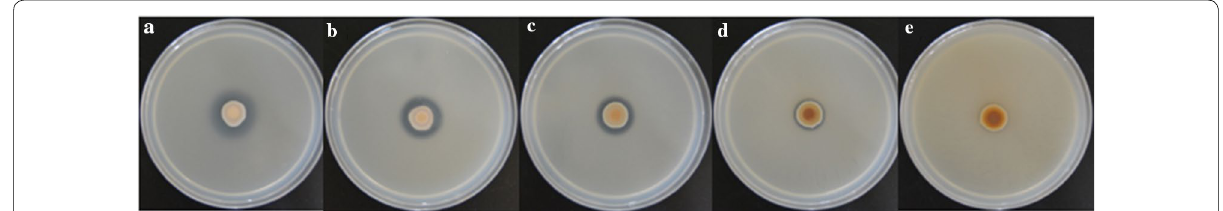
Fig. 2 Growth and phosphate solubilization of WS‑FJ9 on phosphate‑solubilizing plates with different exogenous soluble phosphate concentrations. a . 0 mmol/L; b 1 mmol/L; c 5 mmol/L; d 10 mmol/L; e 20